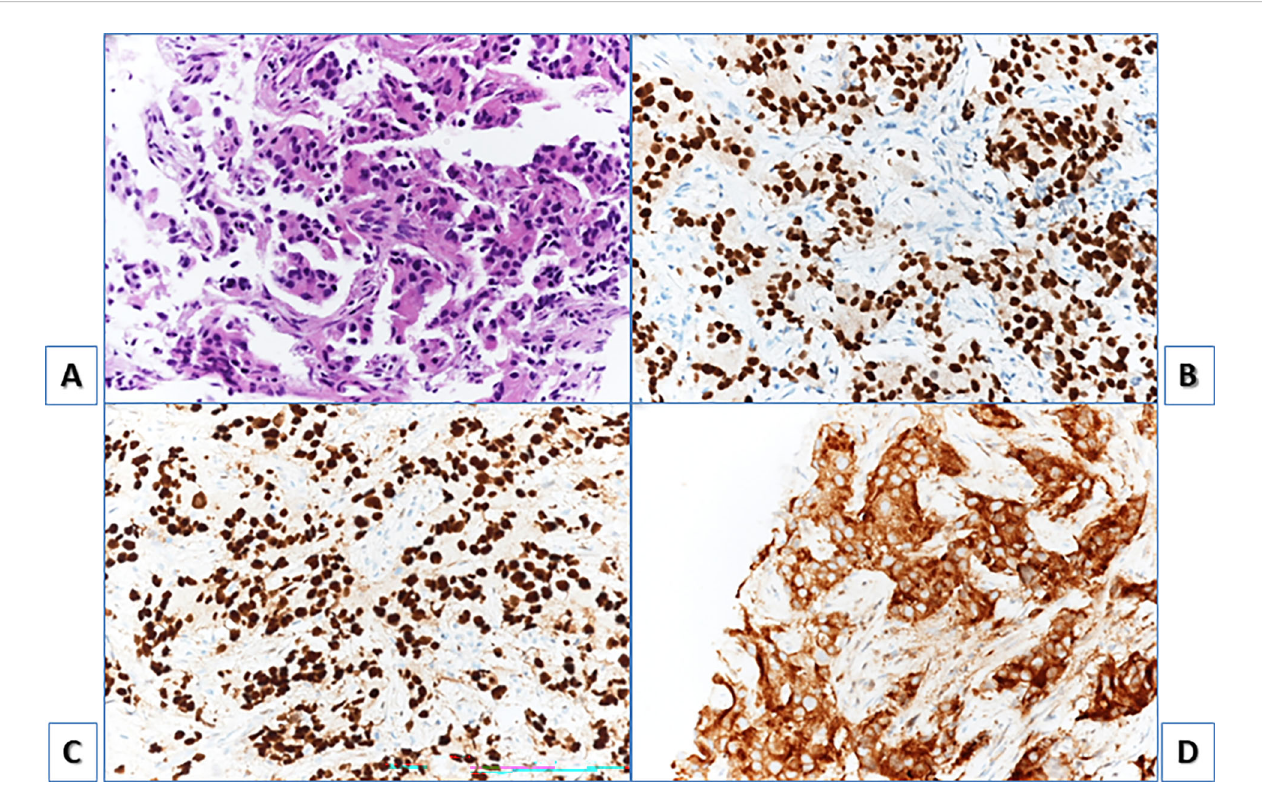
FIGURE 3 H&E staining, showing axillary lymph node biopsy with neoplastic cells with eosinophilic cytoplasm (A) . At immunohistochemistry cells resulted positive for NKX3.1 (B) and androgen receptor (C) with nuclear positivity for both antibody and for PSA (D) cytoplasmatic positivity. They resulted negative for synaptophysin, chromogranin and